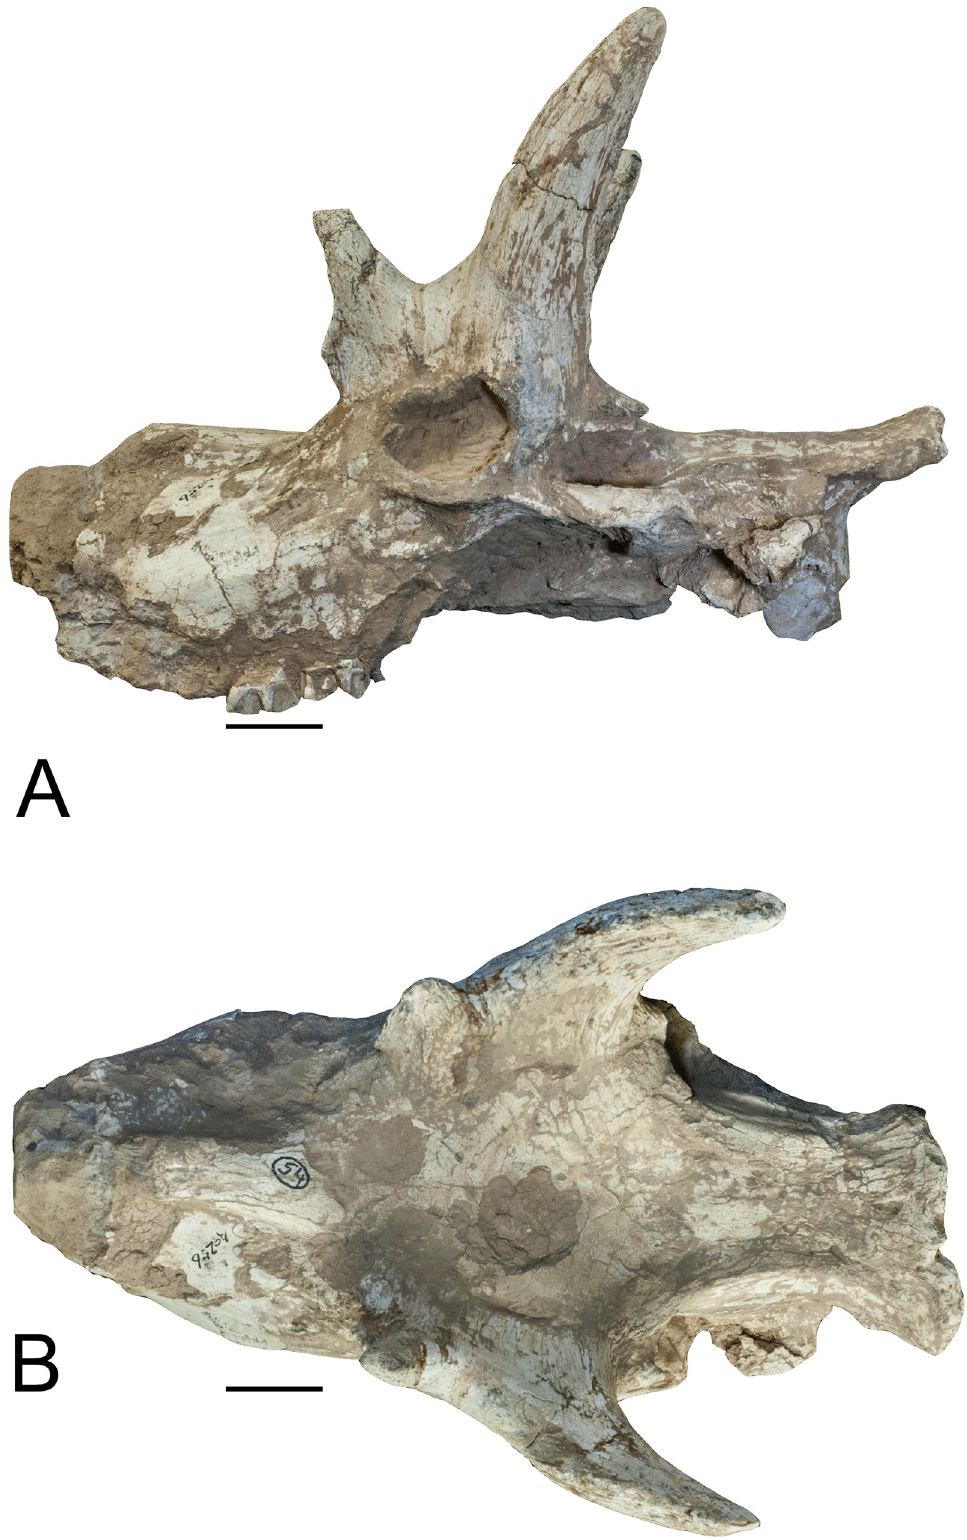
Fig 4. Schansitherium tafeli. (A) HMV 1931 left lateral aspect. (B) Dorsal view. Scale 50mm.